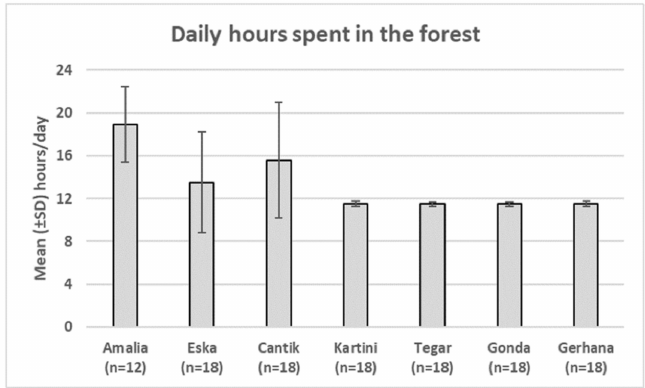
Figure 2. Mean time each rehabilitant spent in the forest per day. The three juveniles started to sleep in the forest increasingly often, therefore the mean can rise above 12 h of daylight. Means are reduced by the inclusion days when the orangutans had to be placed in cages, e.g., due to flooding. N refers to the number of months for which data are